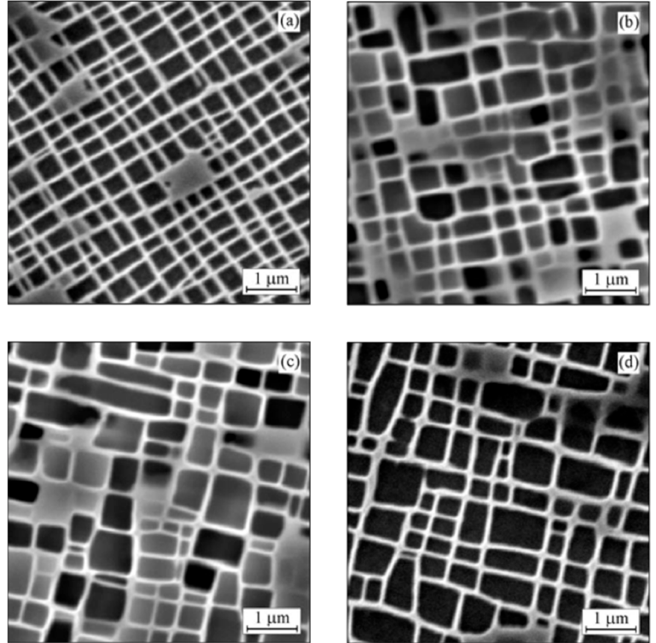
Figure 1. γ / γ ’ microstructure evolution of CMSX-4 superalloy at ( a ) initial state; ( b ) 950 °C/500 h; ( c ) 950 °C/1000 h; ( d ) 950 °C/2000 h [25].